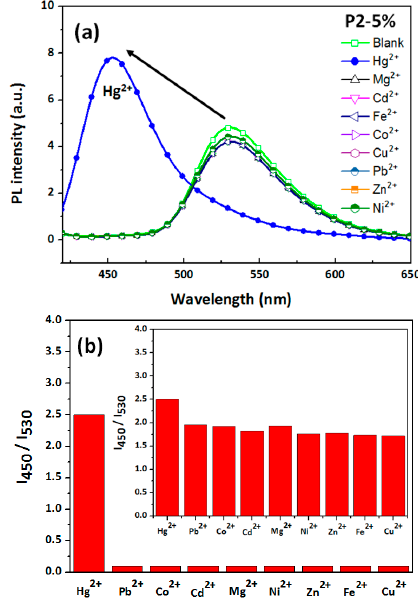
Figure 10. ( a ) Variation in the normalized PL spectra of P2-5% ES nanofibers in aqueous solutions with various metal ions (10 − 2 M) and no cation (blank). ( b ) Fluorometric responses ( I 450 / I 530 ) of P2-5% ES nanofibers to various cations at 10 − 2 M aqueous solutions. From left to right: Hg 2+ , Pb 2+ , Co 2+ , Cd 2+ , Mg 2+ , Ni 2+ , Zn 2+ , Fe 2+ , and Cu 2+ . All the inset figures show corresponding photographs recorded under UV light. Inset of ( b ): fluorimetric response of the P2-5% ES nanofibers to solutions containing various metal ions at 10 − 2 M (as in ( b )) when Hg 2+ at 10 − 2 M is present.